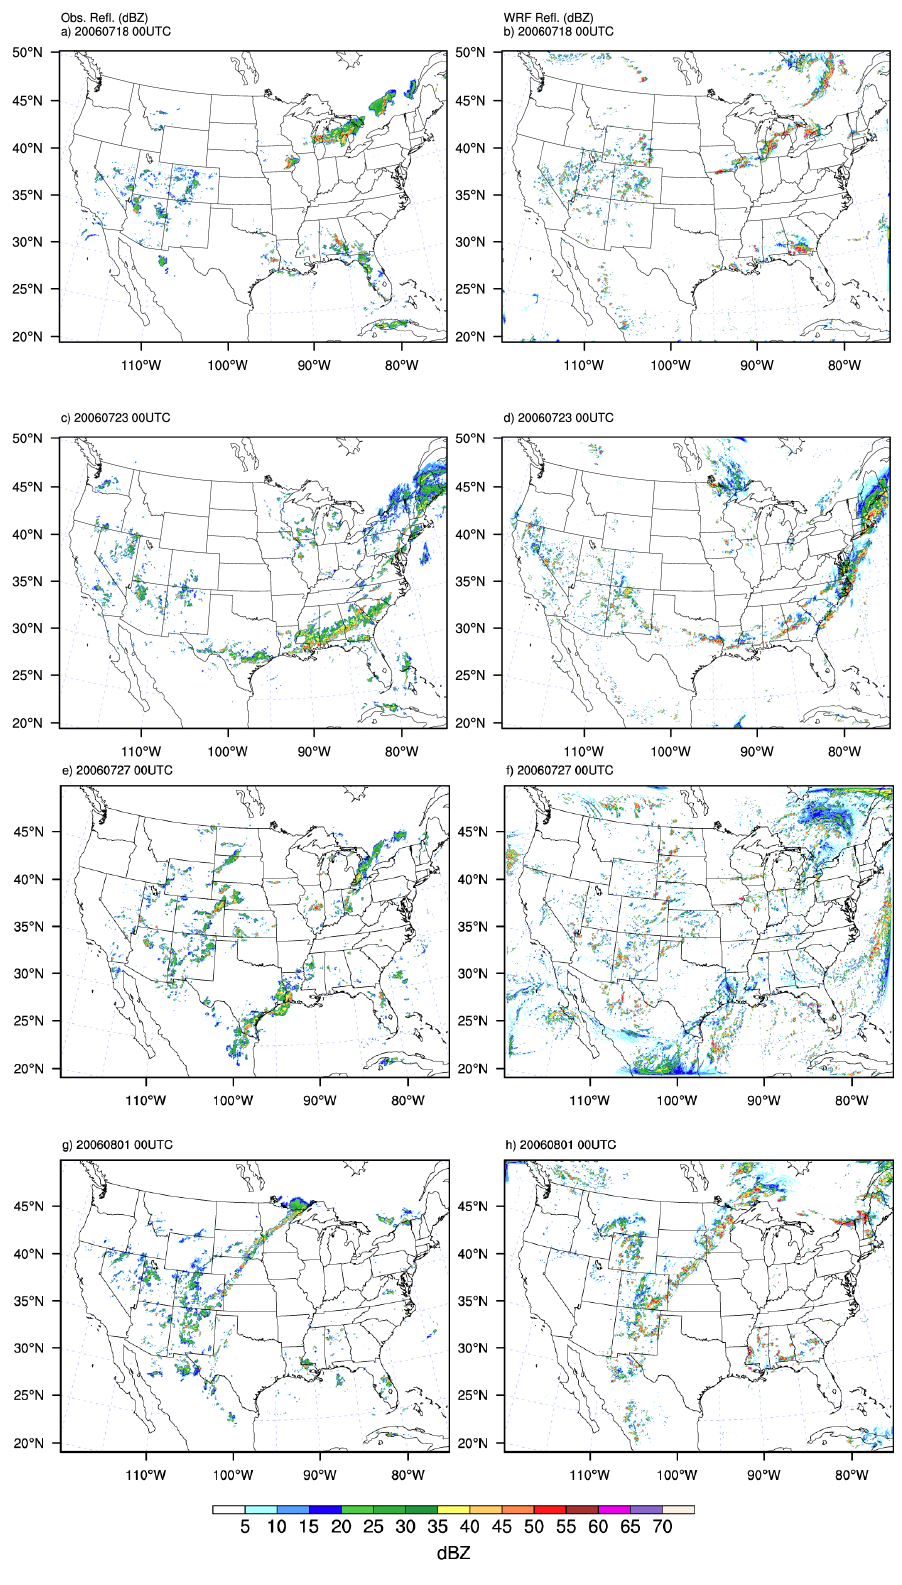
Fig. 3. National Weather Service NEXRAD observed (left panels) and WRF-Chem simulated (right panels) maximum radar reflectivity at 00:00UTC for 18 July 2006 (a, b) , 23 July 2006 (c, d) , 27 July 2006 (e, f) , and 1 August 2006 (g, h) . Note that the observed radar reflectivity is only for the US while the model-derived reflectivity includes storms in Canada and